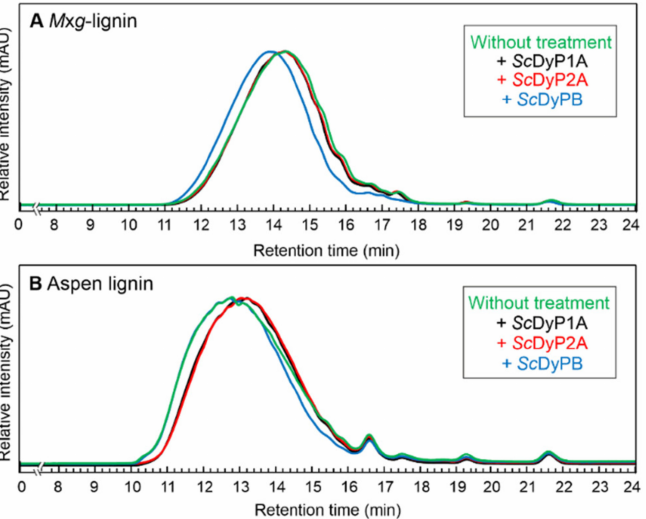
Figure 5. The characterization of lignin-remodeling activities of Sc DyPs by GPC. Panel ( A ) M x g - lignin, panel ( B ) aspen lignin. The treatment of M x g- lignin with Sc DyPB led to the polymerization of lignin polymer. The treatment of aspen lignin with Sc DyPAs resulted in lignin depolymerization. Table 5. The most prominent LMW compounds found in M x g -lignin (A) and aspen lignin (B), and the influence of Sc DyPs treatment to the peak area reduction. The peak areas are represented in percentages where the result from the untreated sample is set to 100%, and the treated samples are defined as the percentage peak area left after the